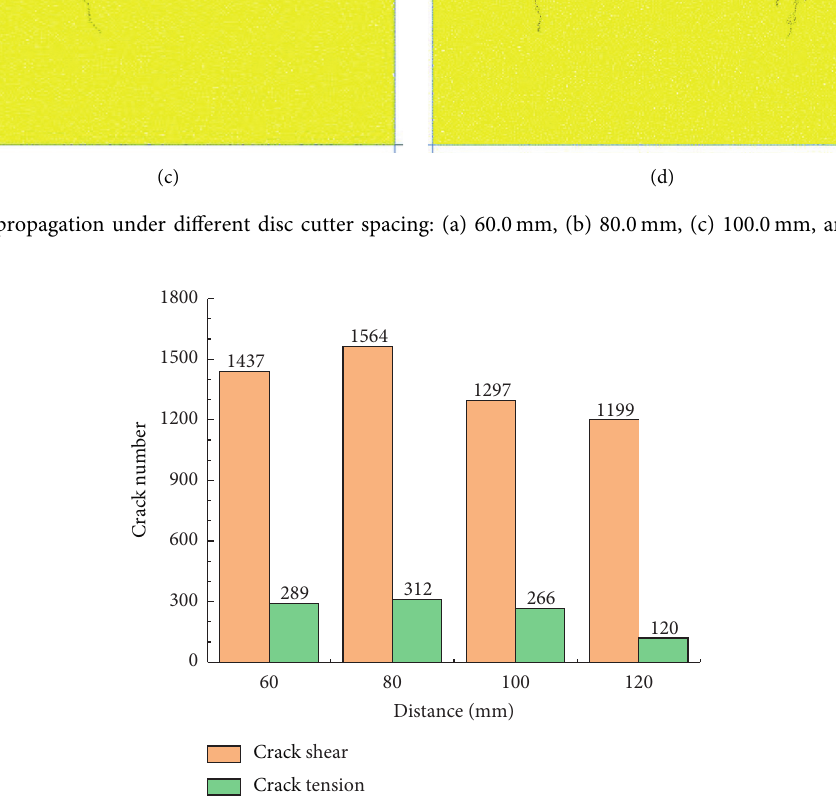
Figure 10: Statistics of the number of cracks under different disc cutter